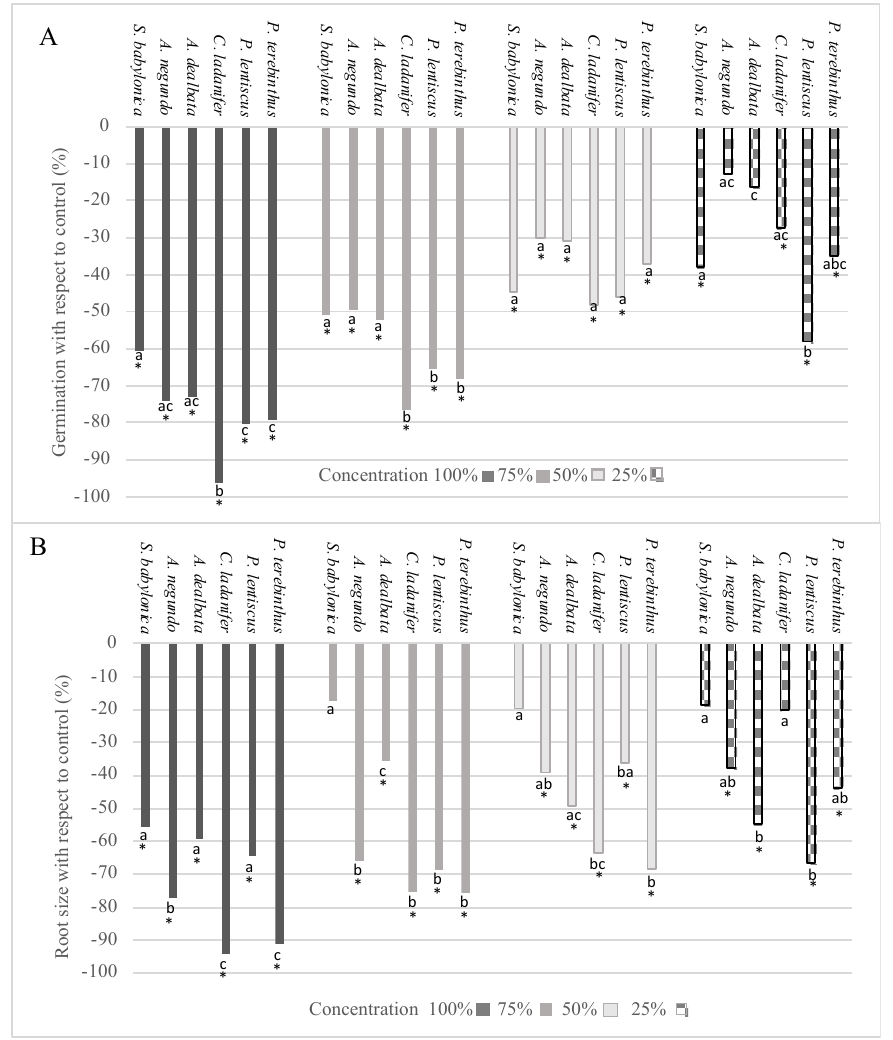
Figure 1. Effect of S. babylonica, A. negundo, A. dealbata, C. ladanifer, P. lentiscus, and P. terebinthus extract on germination ( A ) and root size ( B ) of L. sativa at 100%, 75%, 50%, and 25% concentrations; a, b, c: lowercase letters indicate significant differences between species of the same concentration (Mann-Whitney test, p < 0.05). *: Significant difference of control (Mann-Whitney test, p <